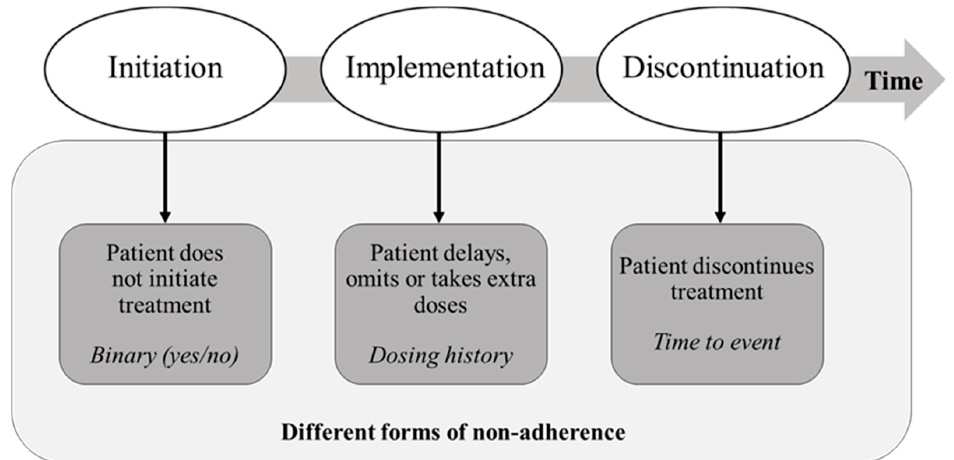
Figure 1. Phases of medication adherence according to the ABC Taxonomy. Based on Vrijens et al., Br J Clin Pharmacol 2012 [13]. J. Clin. Pharmacol. 2012